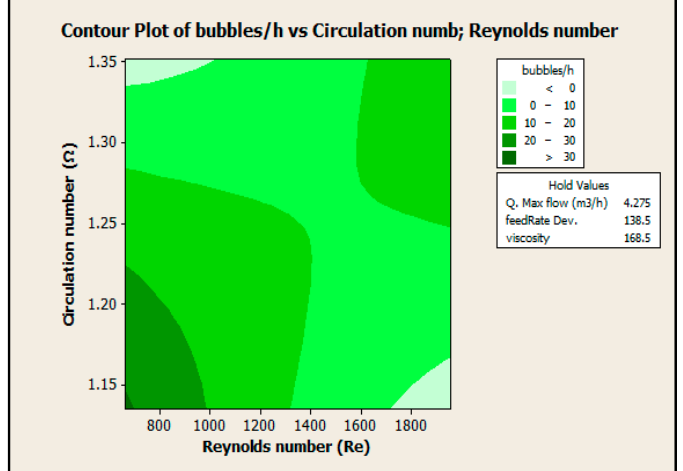
Figure 17. The relationship between Ω and (Re) to control the bubbles